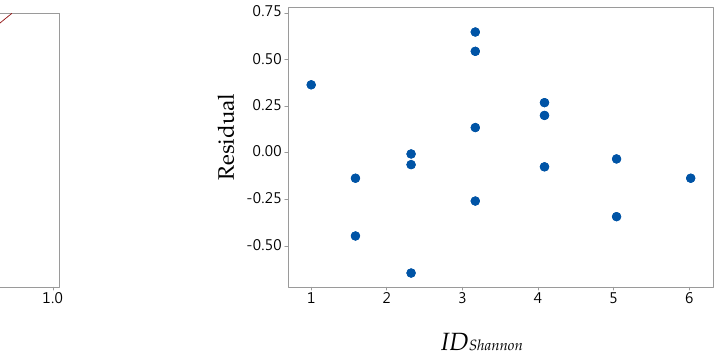
Figure 3. The normality plots of the residuals in the 1 oz stylus tapping task using the SQRT_MT model with ID Shannon . The left side is residual vs. response percentage in the AD test; the right side is residual vs. ID Shannon . The normality assumption was satisfied.